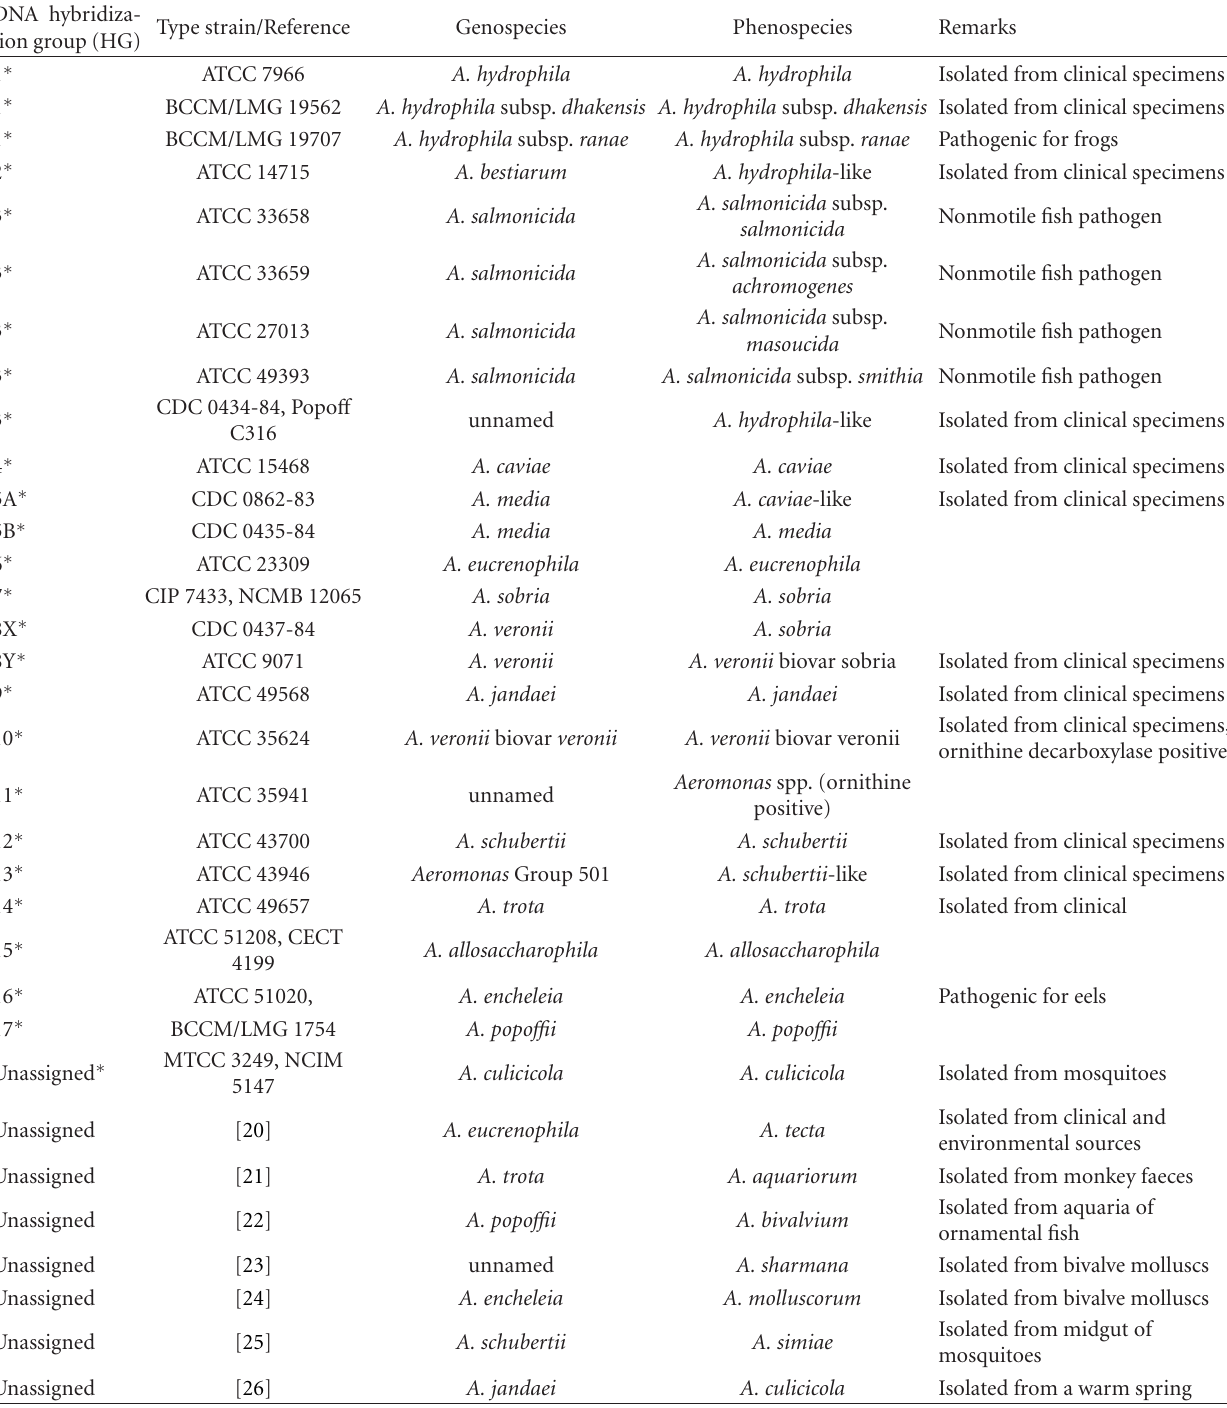
Table 1: Hybridization groups (genomospecies) and phenospecies of the genus Aeromonas . DNA hybridiza- Type tion group (HG)